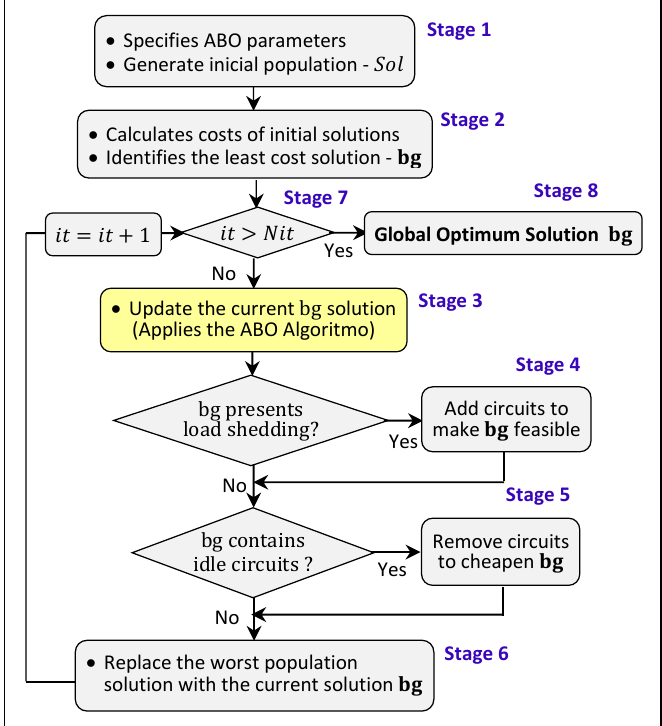
Figure 2: Flowchart of the ABO (N-1)